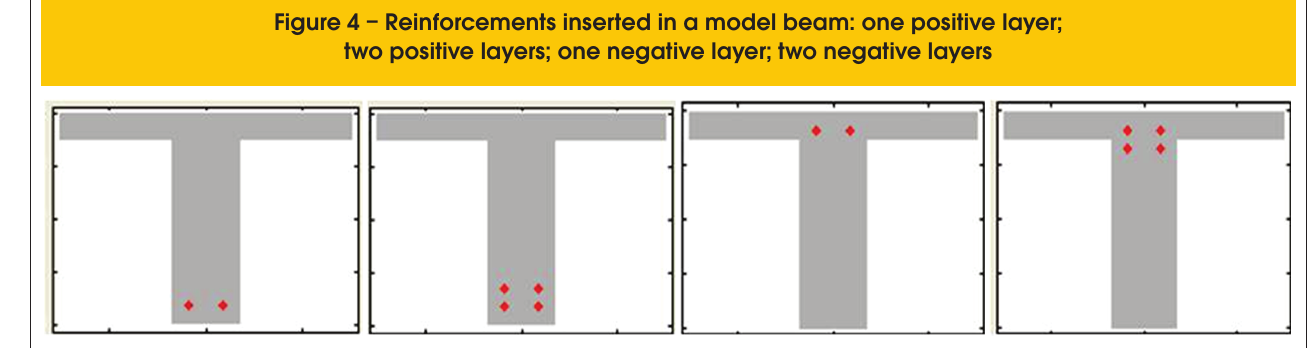
Figure 4 – Reinforcements inserted in a model beam: one positive layer; two positive layers; one negative layer; two negative